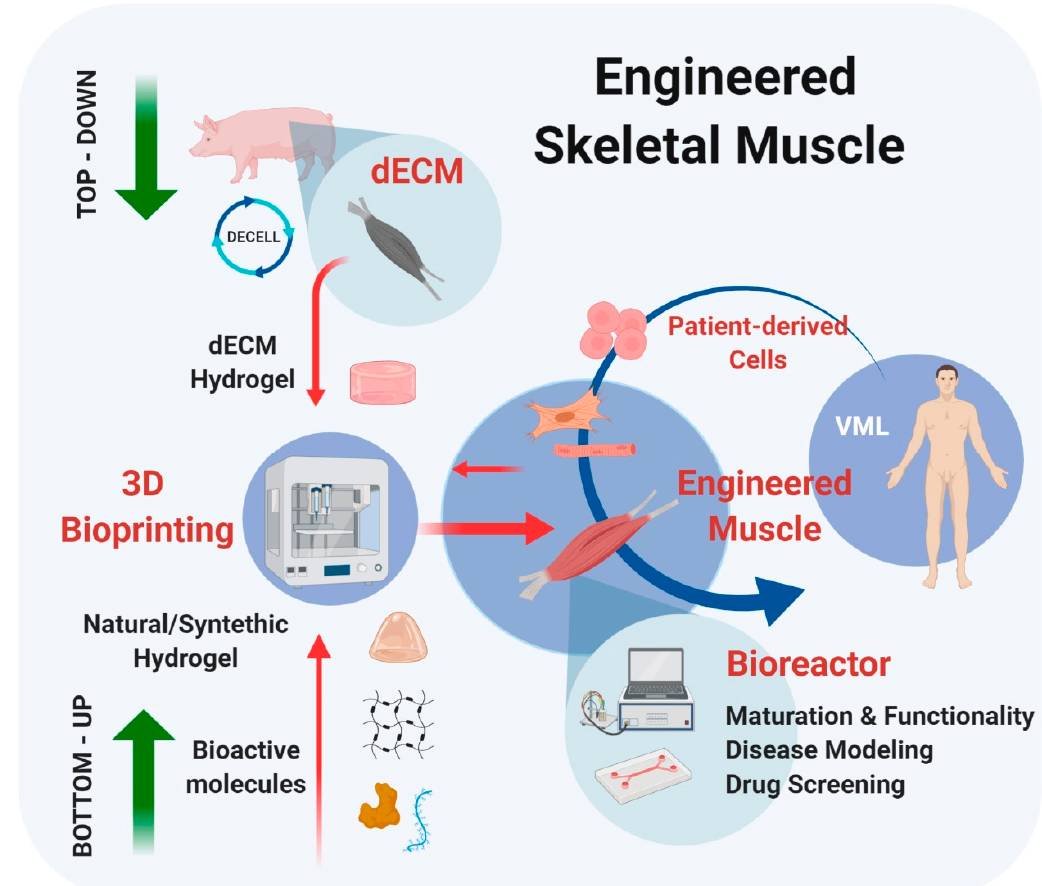
Figure 2. SKM tissue engineering strategies based on bottom-up and top-down parallel approaches. Bottom-up: generation of artificial biomaterials starting from natural-derived/synthetic hydrogels combined with specific bioactive molecules. Top-down: generation of dECM bioinks starting from animal (or human) samples. The 3D printing of these different types of SKM hydrogels will allow the production of (patient) specific tissue-like constructs for in vitro disease modeling and drug screening, and in vivo tissue replacement. Schematic was made using BioRender (https://app.biorender.com).